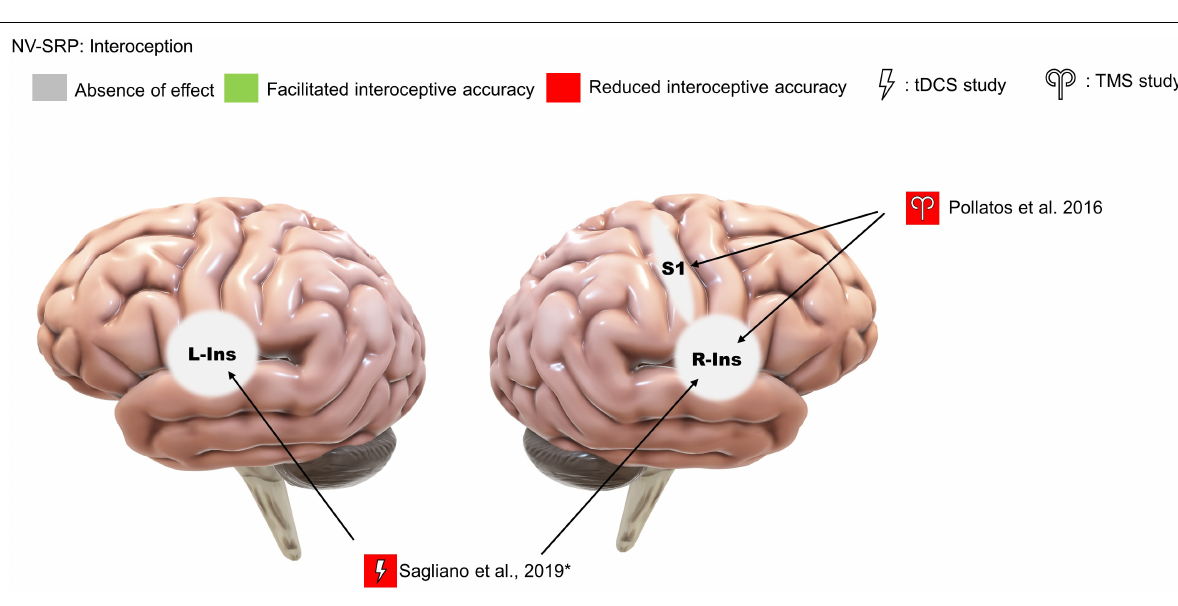
the causal role of the left and right insula in both cardiac and respiratory interoception ( Figure 7 ; for the right